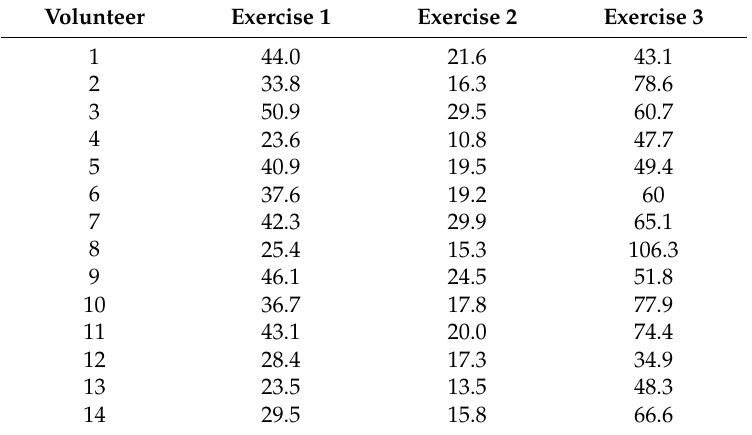
Table 3. Automatic measurements of the duration of the exercises, time, is represented in seconds. Volunteer